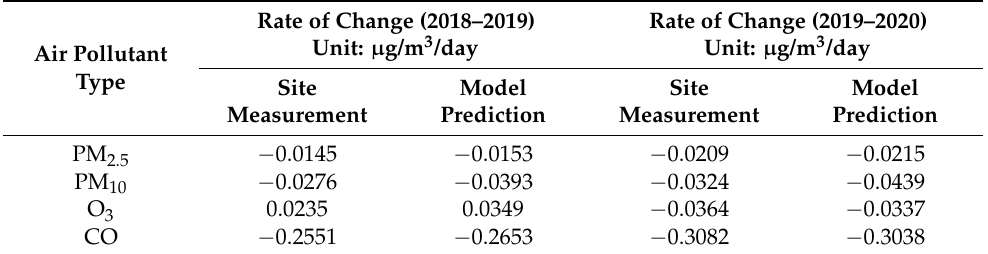
Table 1. The rates of changes of daily PM 2.5 , PM 10 , O 3 , and CO concentration based on site measure- ment and model prediction from 1 January 2018 to 31 December 2020 over Central and Eastern